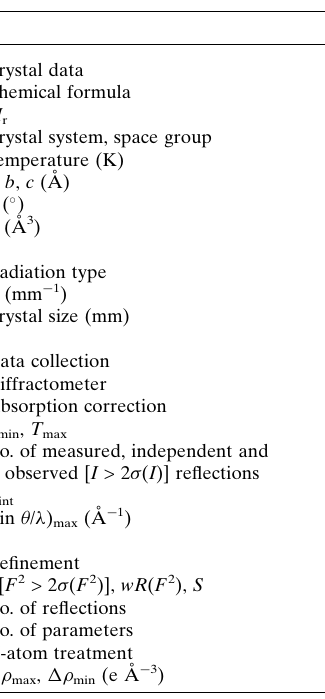
Table 5 Experimental details.